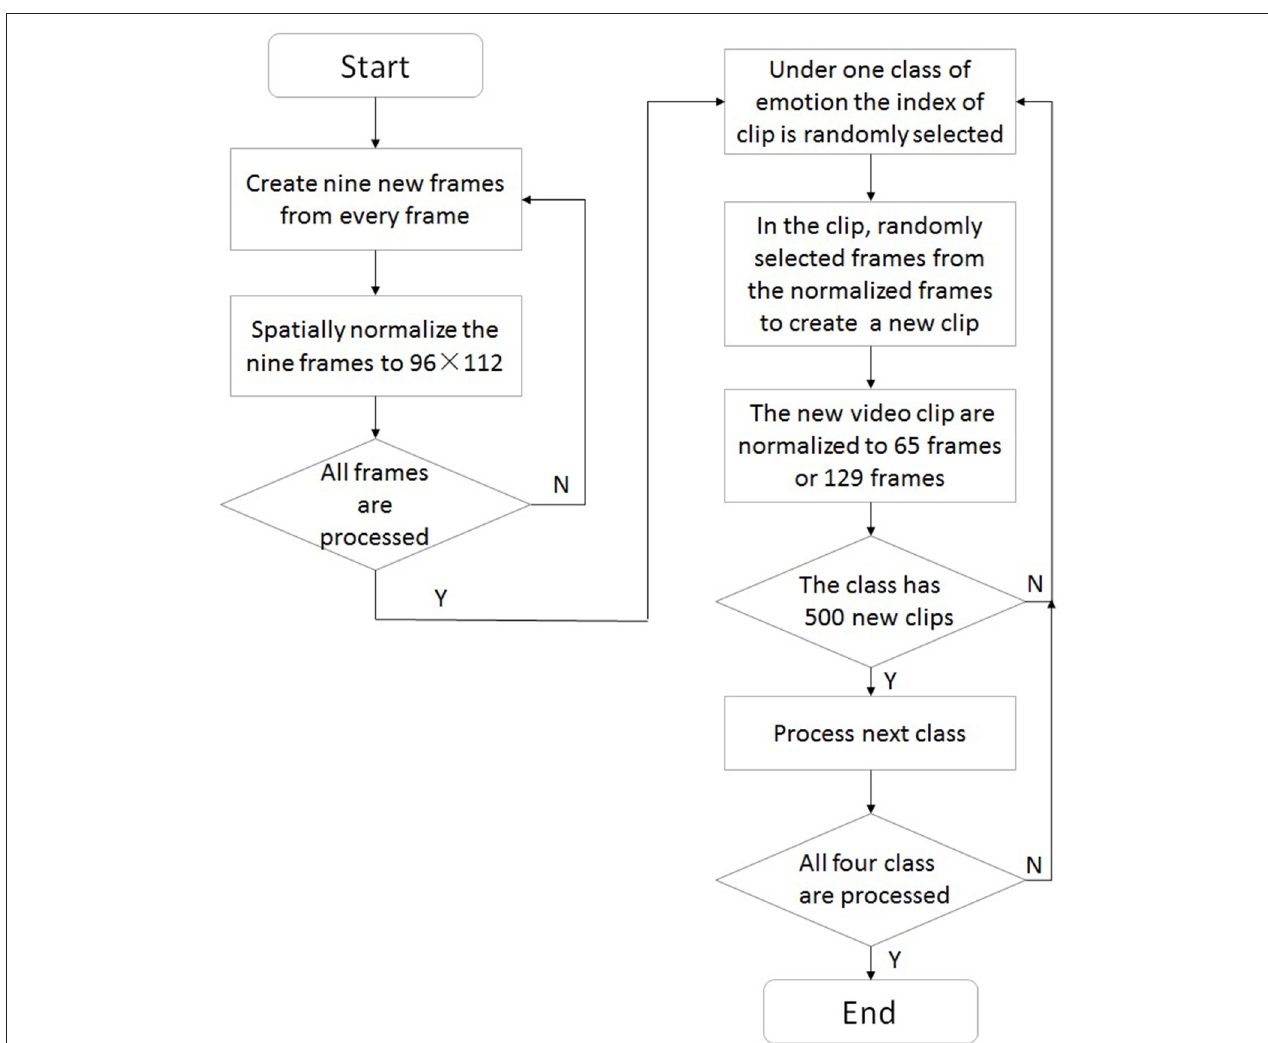
FIGURE 6 | Flow chart of the sampling